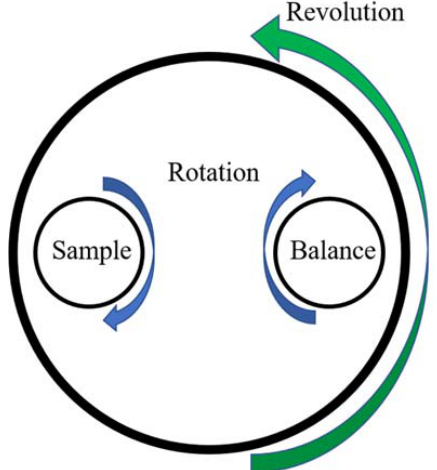
Figure 2. The illustration of the working principle of the planetary centrifugal mixer.